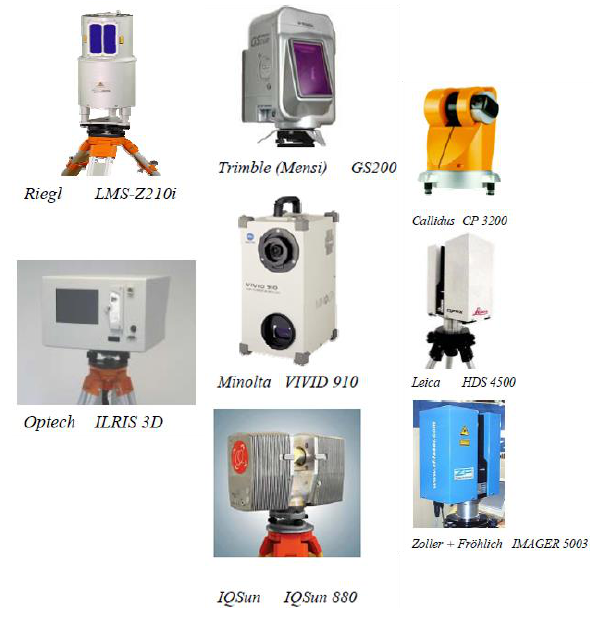
Figure 1. Laser scanners (adopted from GIM International,